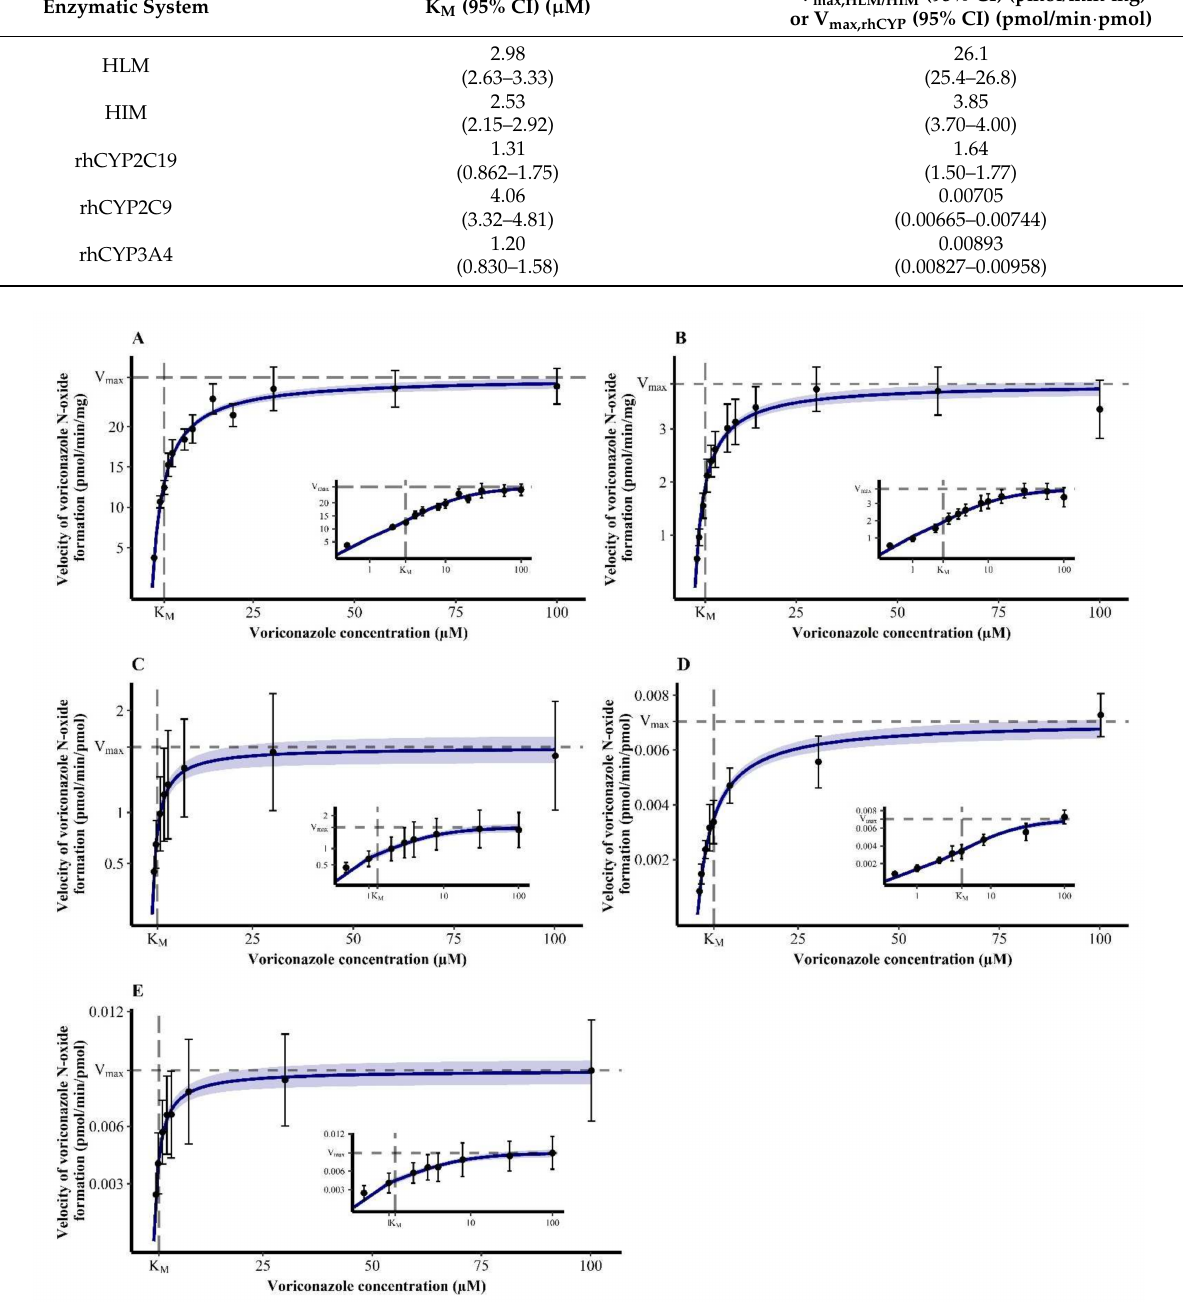
Figure 2. Michaelis-Menten kinetics of the N -oxidation of voriconazole in human liver microsomes (( A ), n = 8–9), human intestine microsomes (( B ), n = 9) and recombinant human cytochrome P450 2C19 (( C ), n = 18), 2C9 (( D ), n = 10) and 3A4 (( E ), n = 18). Insets show the respective plot with a log-transformed x -axis. Data points—mean reaction velocity; error bars—standard deviation of reaction velocity; solid blue line—estimated enzyme kinetics; shaded area—95% confidence interval of the estimation; dashed lines—estimated Michaelis–Menten constant (K M ) and maximum reaction velocity (V max